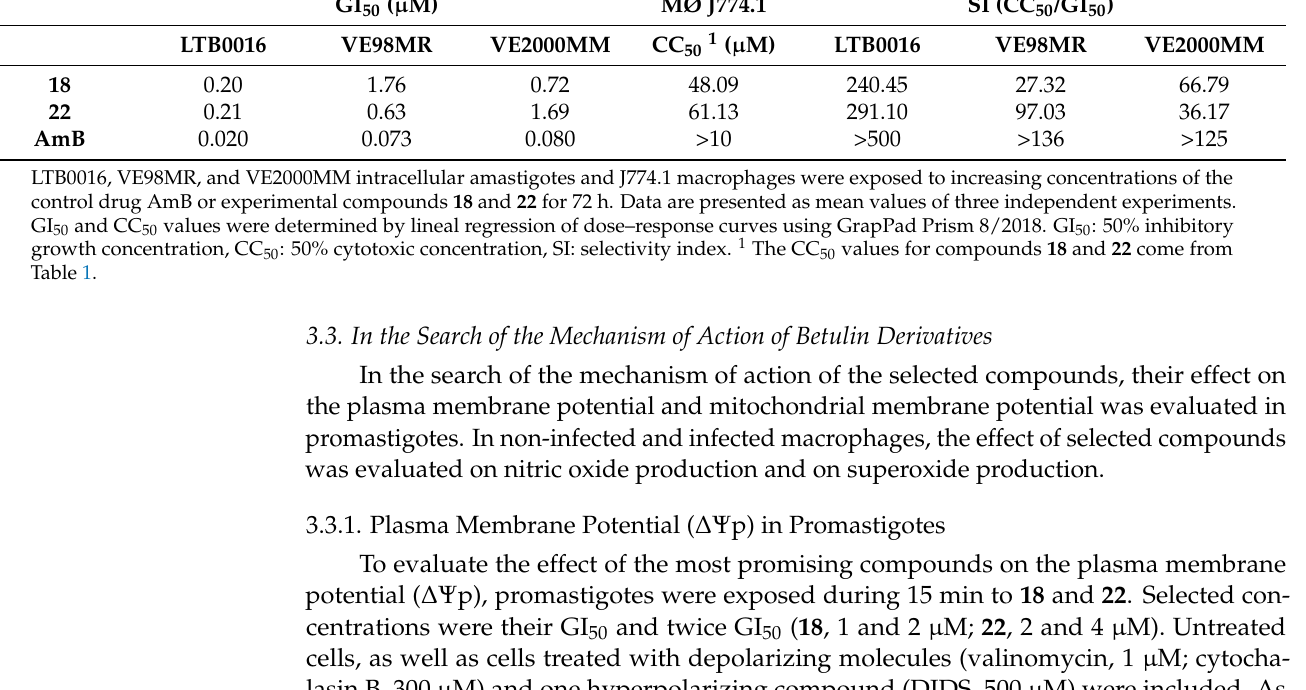
Table 2. In vitro activity of compounds against intracellular amastigotes of the reference strain LTB0016 and patient isolates VE98MR and VE2000MM. GI 50 ( µ M) MØ J774.1 SI (CC 50 /GI 50 ) LTB0016